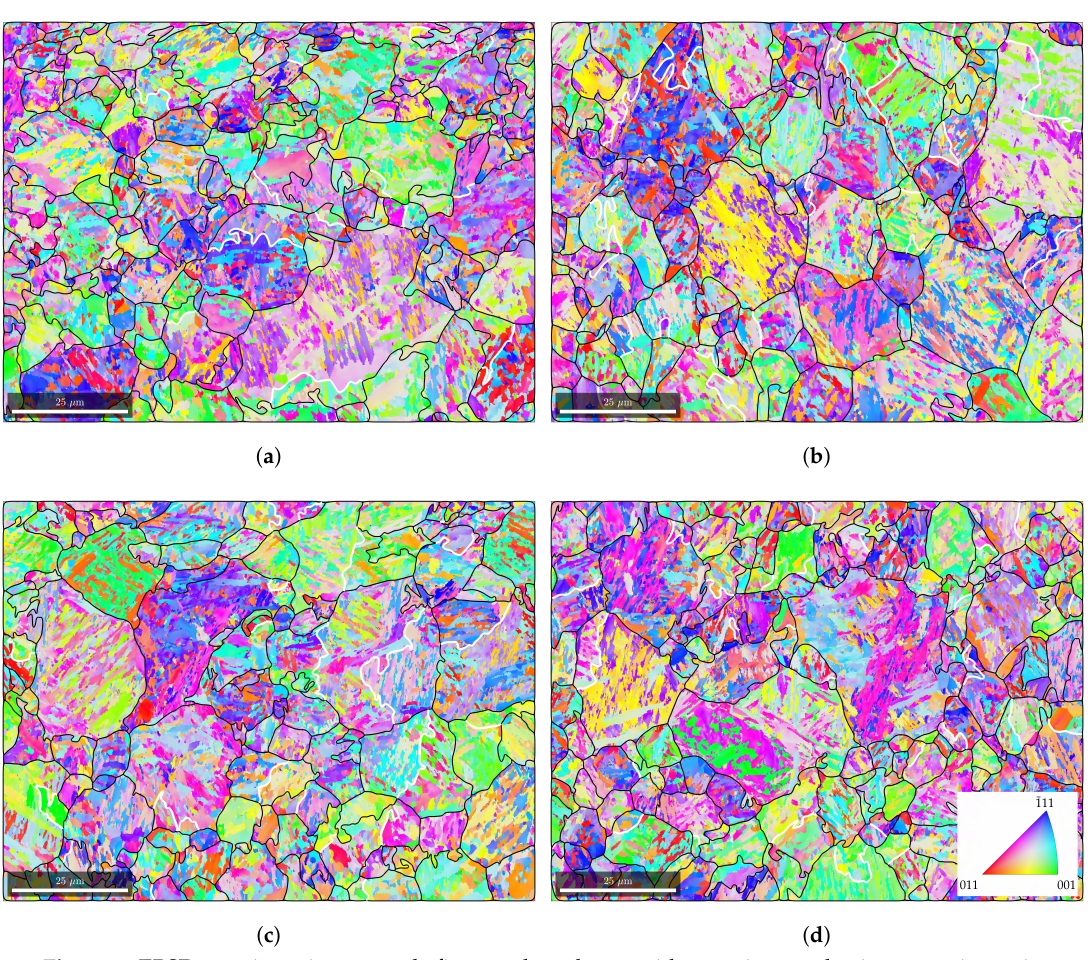
Figure 5. EBSD map in an inverse pole figure color scheme with superimposed prior austenite grain boundaries (black) and recrystallization twin boundaries (white): ( a ) A1, ( b ) A2, ( c ) A3, ( d )